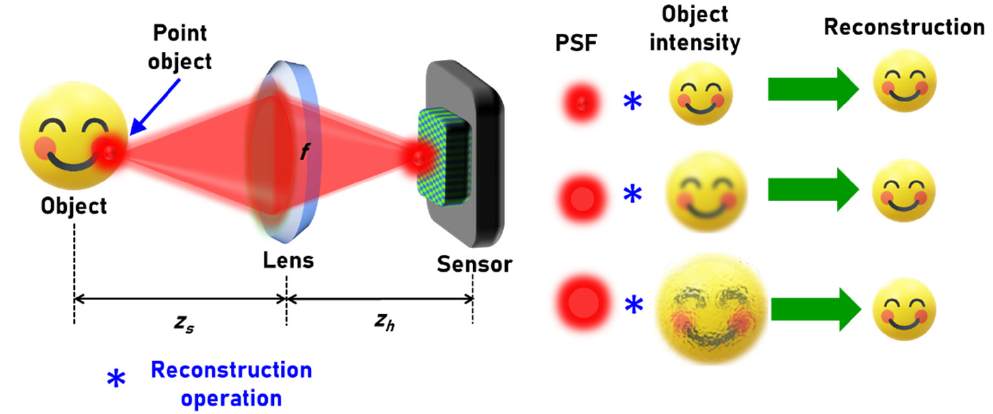
Figure 1. Concept figure of imaging using a refractive lens and computational reconstruction. In the direct imaging mode, I O is obtained by sampling of O by I PSF and therefore when the imaging condition is satisfied, the object information gets sampled by the lateral resolution of the system. When the imaging condition is not satisfied, the I PSF is blurred and so is the object information. In indirect imaging mode, the task is to extract O from I O and I PSF . A direct method to extract O is to cross-correlate I O and I PSF as I R = I O ∗ I PSF which is given as I R = I PSF ⊗ O ∗ I PSF . Rearranging the terms, we obtain I R = O ⊗ I PSF ∗ I PSF . So, the reconstructed information is the object information sampled by the autocorrelation function of I PSF . The width of the autocorrelation function cannot be smaller than the diffraction limited spot size under normal conditions. When the imaging condition is satisfied or when a diffuser is used, the autocorrelation function is sharp. When the imaging condition is not satisfied, then the autocorrelation function is blurred, making the correlation-based reconstruction not effective. The advanced version of correlation given as a non-linear reconstruction is effective in reducing the background noise arising due to the positive nature of the I PSF during correlation but is affected by the nature of the intensity distribution [24,26]. The non-linear reconstruction is given as